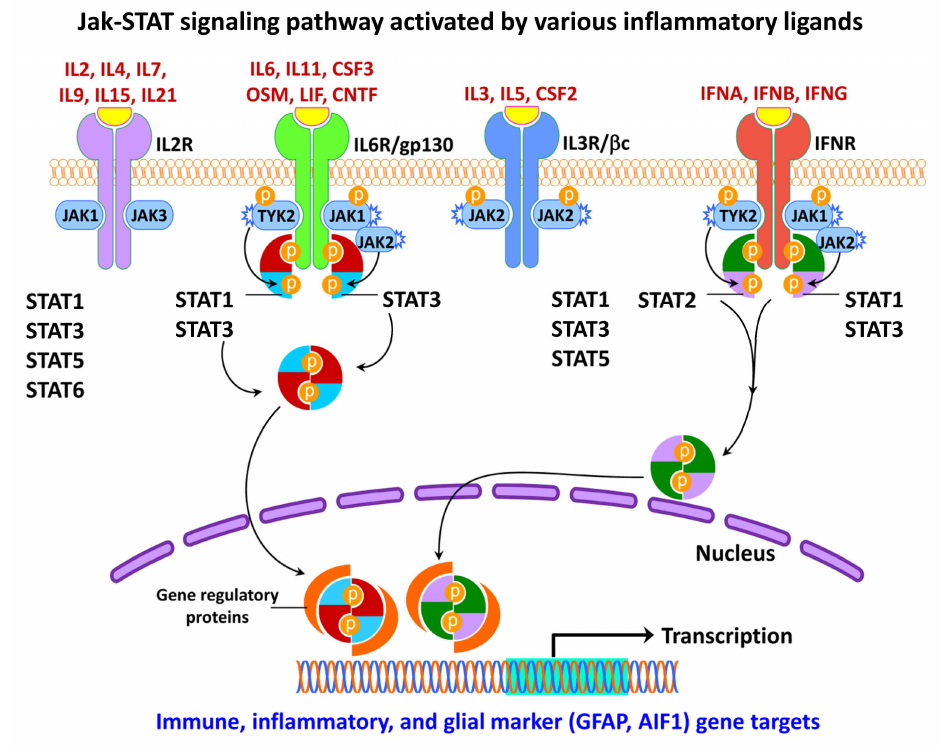
Figure 7. JAK-STAT signaling in neuroinflammatory response. Schematic representation depicting activation and regulation of JAK/STAT signaling pathways by various inflammatory ligands. The JAK family has four main members: JAK1, JAK2, JAK3, and TYK2. Black arrows indicate the activation process. Inflammatory mediators and growth factors bind to their corresponding receptors leading to receptor dimerization and recruitment of related JAKs. These mediators include, but are not limited to, interferons, such as interferon alpha, interferon beta, and interferon gamma; interleukin 2, interleukin 3, interleukin 4, interleukin 5, interleukin 6, interleukin 7, interleukin 9, interleukin 11, interleukin 15, interleukin 21; colony stimulating factor 2, colony stimulating factor 3; oncostatin M; leukemia inhibitory factor; and ciliary neurotrophic factor. JAK activation leads to tyrosine phosphorylation of the receptors and the formation of docking sites for various STATs. The activated JAKs phosphorylate (P) and activate STATs. Some JAKs are associated with many different cytokine receptors, but JAK3 associates with only IL2, predominantly to its gamma chain subunit. The STAT family consists of six members: STAT1, STAT2, STAT3, STAT4, STAT5 and STAT6,